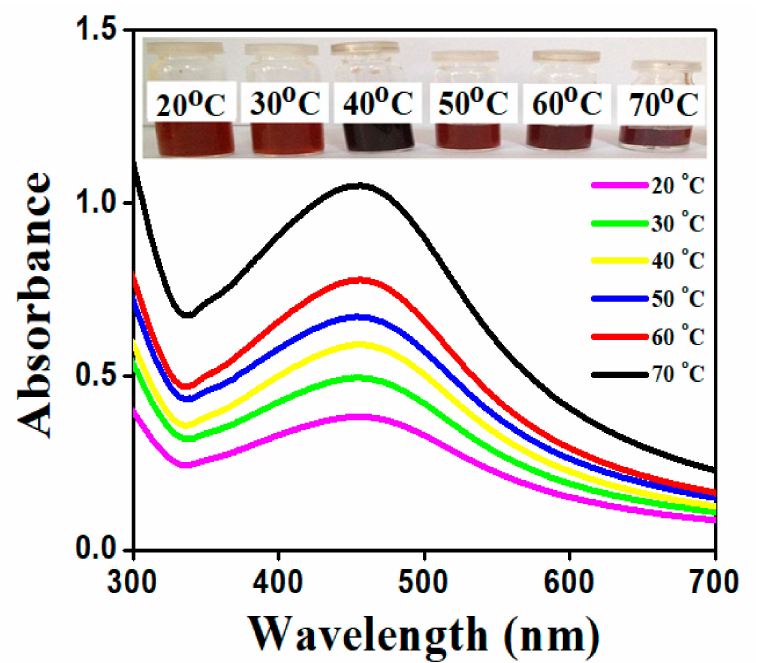
Figure 4. Absorption spectra of AgNPs achieved at different reaction temperatures using S. procum- bens plant extract AgNPs.